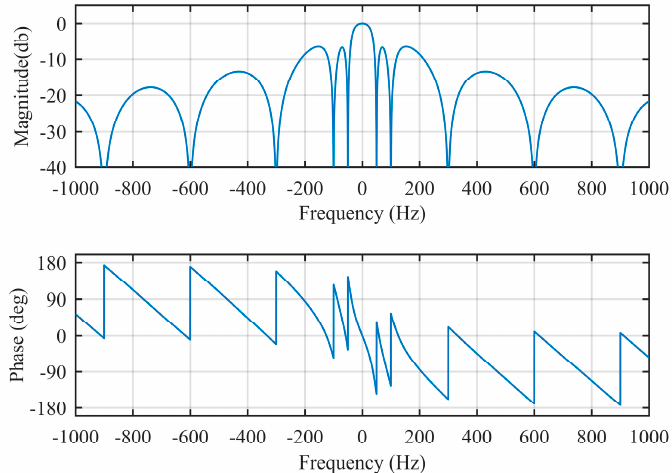
Figure 9. Frequency response of H dc (s).